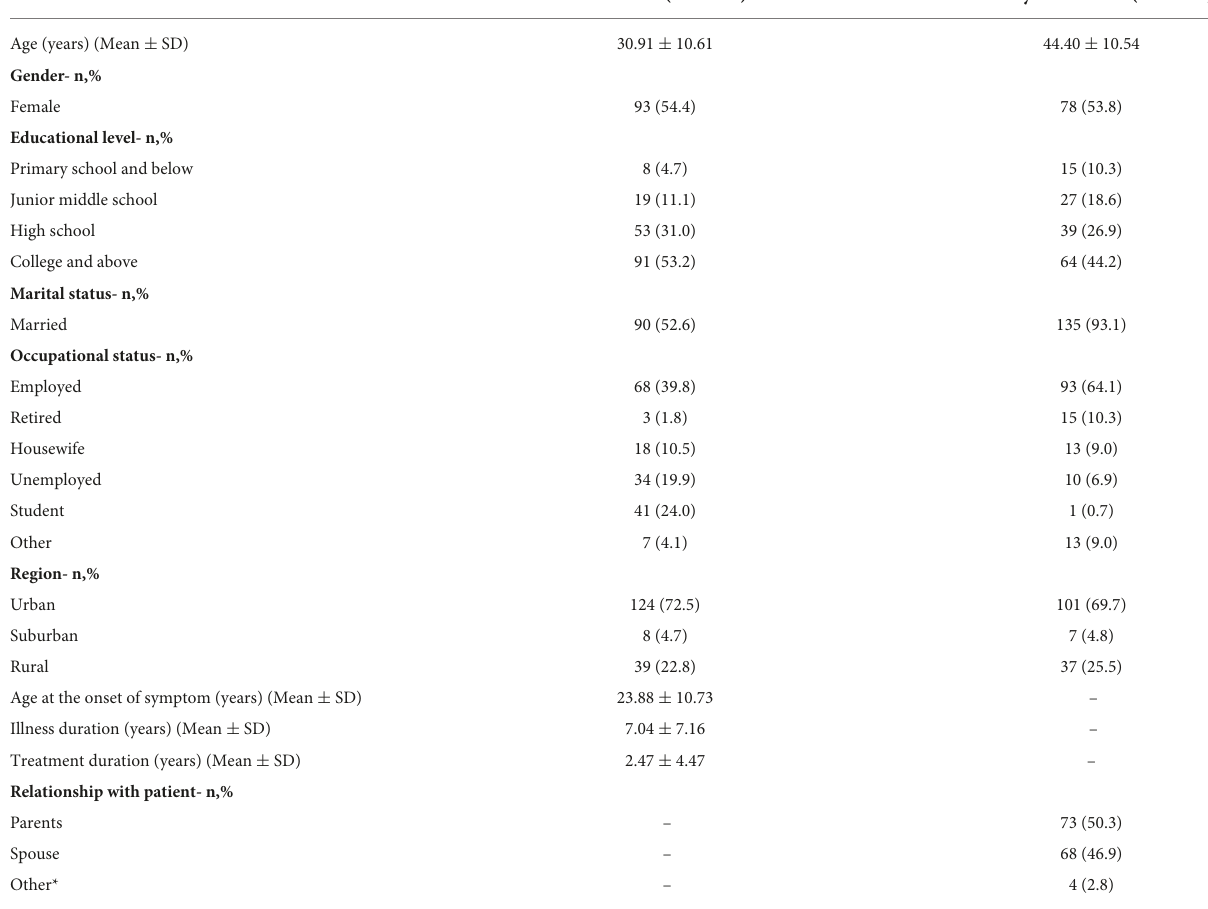
TABLE 1 Demographic and clinical characteristics of